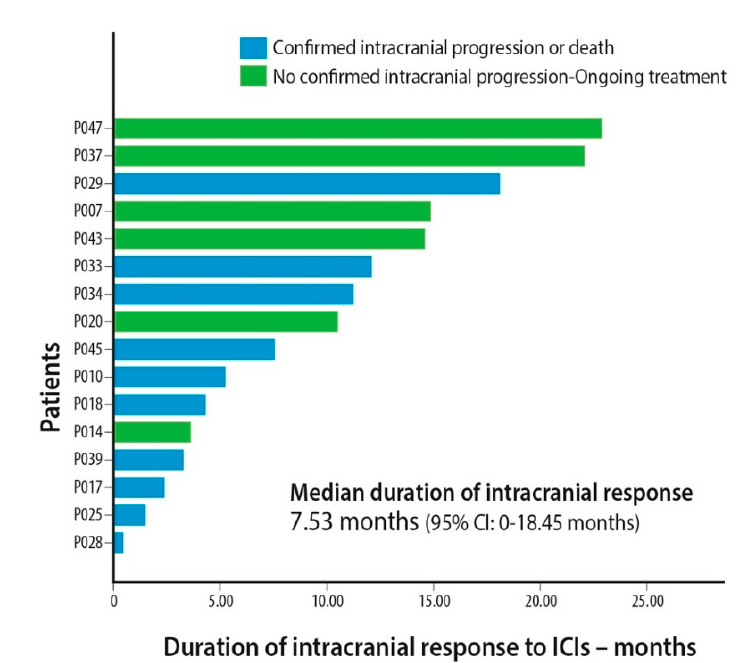
Figure 1. Intracranial duration of response for each patient that achieved partial response or disease stabilization in CNS lesions. Abbreviations: ICIs = Immune Checkpoint Inhibitors, 95% CI = 95% Confidence Interval.